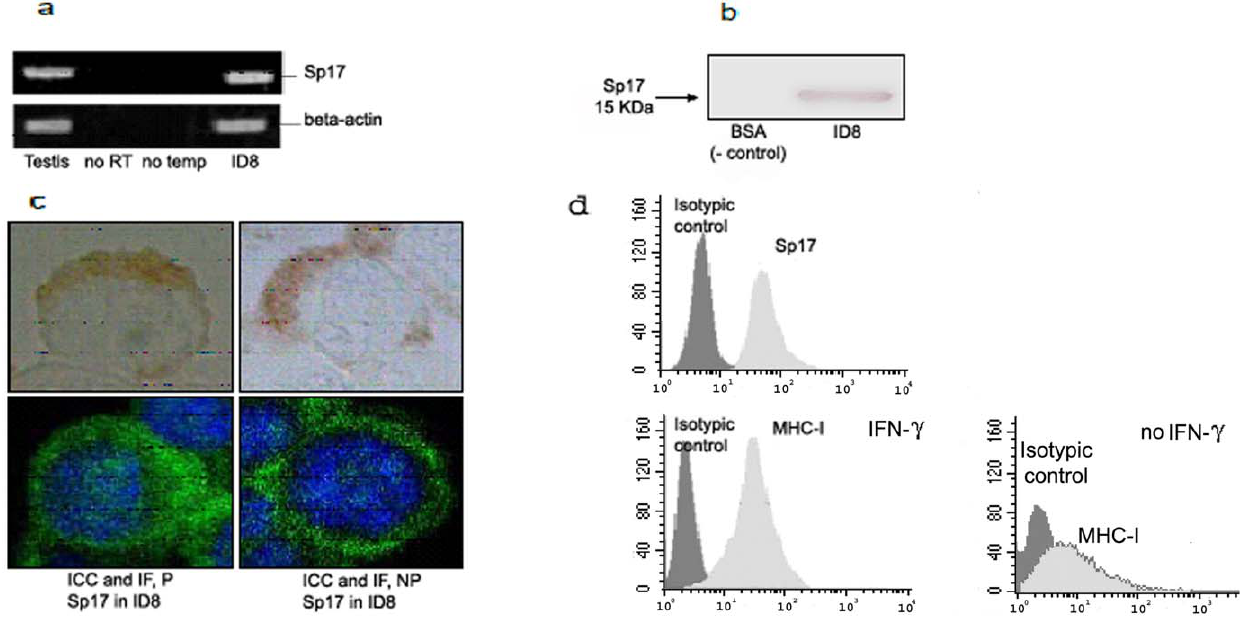
Figure 1. Analysis of Sp17 expression in ID8 cells. Sp17 mRNA in the murine ID8 tumor cells and in mouse testis (positive control). The mRNA levels were analyzed by RT-PCR for Sp17 expression. A cellular housekeeping gene, B-actin, was included as a control. A PCR-only control (no RT step) failed to generate a product, indicating that there was no DNA contamination in the samples. In addition to the RT-PCR (see figure 1a ), Western blot was performed and figure 1b shows the expression of Sp17 at the protein level. The ID8 cell line was further characterized by an immunocytochemistry (ICC) and immunofluorescence (IF). This figure shows a cytospin of ID8 cells permeabilized (P) and a positive staining for Sp17 at the cytoplasm level. In addition, Sp17 was confirmed by IF in the cytoplasm. Additionally, in figure 1c, the non permeabilized (NP) cells show clear expression via IF and less by ICC. Panel d shows ID8 characterization for surface expression of Sp17 and MHC-I; isot. ctrl, isotypic control antibody; percentage indicate positive-staining cells. MHC-I expression was evaluated with or without IFN-g stimulation.